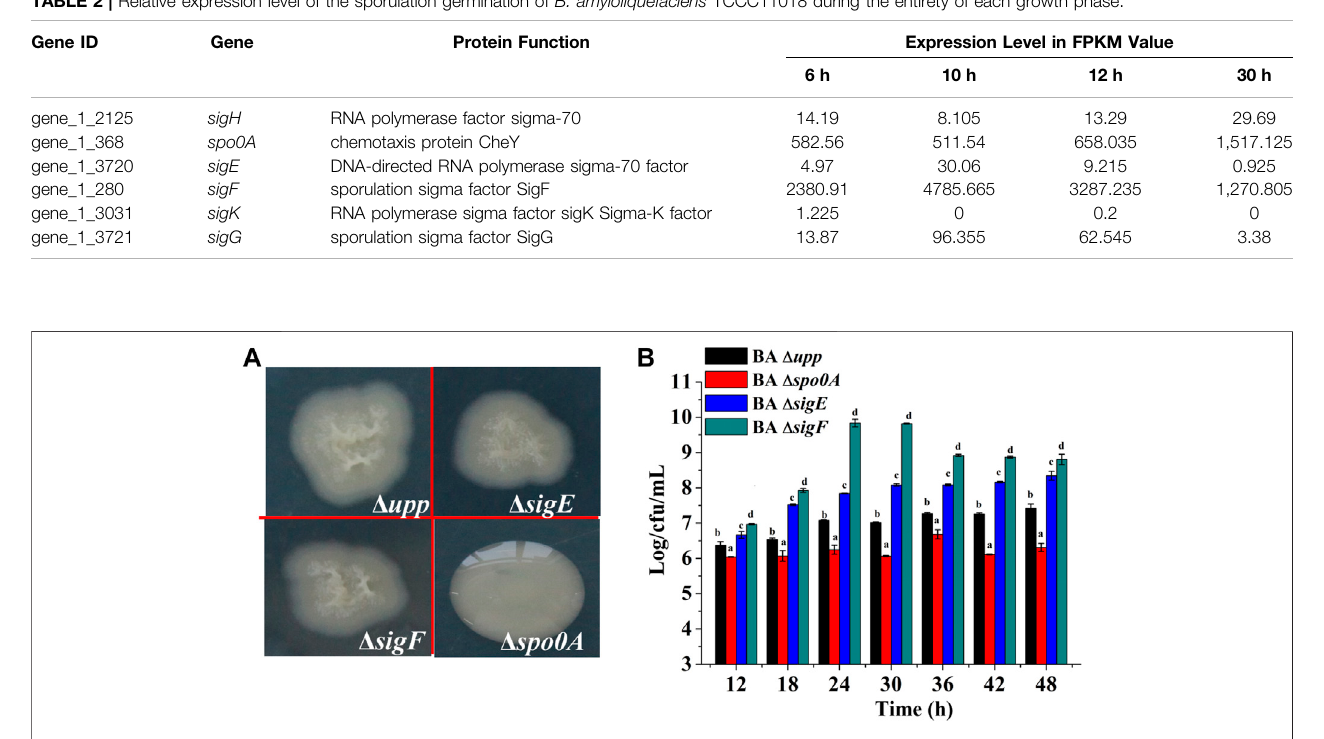
FIGURE 3 | Characterization of knockout strains lacking sporulation-related gene and the parental strain. (A) The colony morphology of the sporulation-de fi cient strains (BA Δ sigE , BA Δ sigF and BA Δ spo0A ) and control strain BA Δ upp on LB plates. (B) The viable counts of the different strains was measured by culturing in LB medium, at 12, 24, 36 and 48 h, respectively. Data are presented as mean values SD. n = 3 biologically independent samples. Means with the different letters are signi fi cantly different according to Duncan ’ s multiple range test at p <